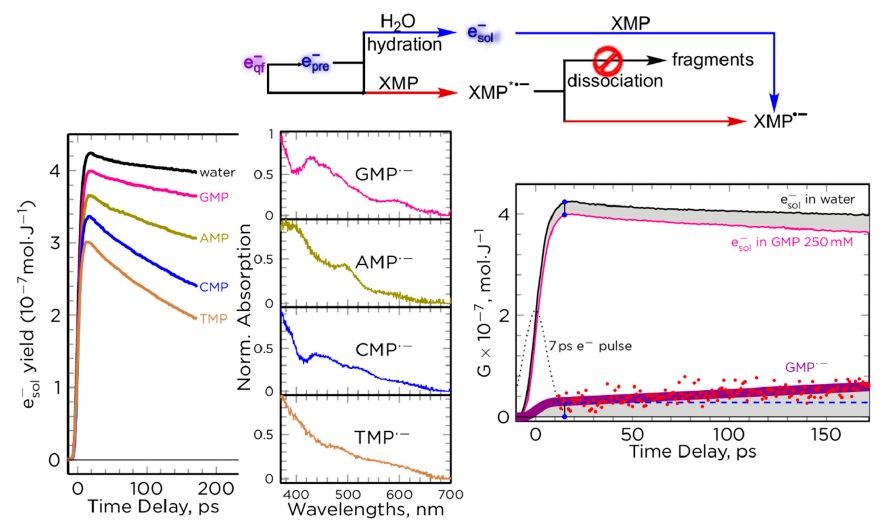
Figure 5. Reactivity of e qf − and / or e pre- toward nucleobases and nucleotides in aqueous solution. Right: Yield of the solvated electron versus time and the absorption spectra obtained in addition to that of the e sol - just after the electron pulse. Left: The kinetics of electron and various nucleotides in solution at ambient temperature. Upper part: Mechanism of electron scavenging in solution by various nucleotides also at ambient temperature [74]. Reprinted with permission from [74]. Copyright 2017 American Association for the Advancement of